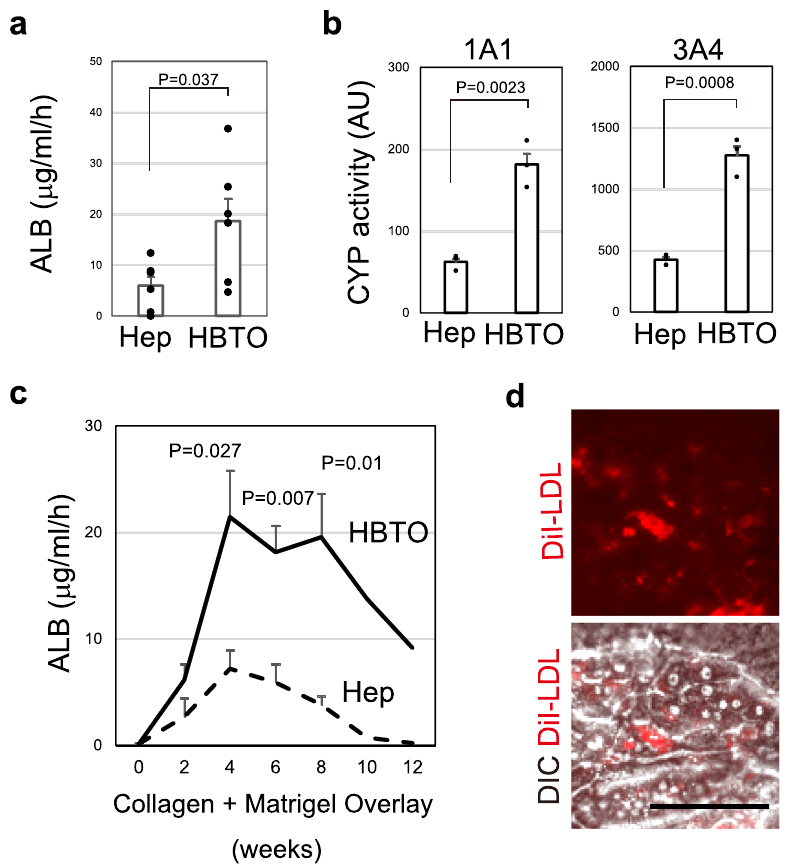
Fig. 4 Hepatocytes maintain metabolic functions in HBTO. a ALB secretion from hepatocytes and HBTOs. Hepatocytes in HBTOs secrete more ALB than those cultured alone. SHs were plated onto collagen gel with or without cholangiocyte colonies. Culture medium was collected, and ALB concentration was examined by ELISA four weeks after Col-MG overlay. Six wells ( n = 6) cultured independently were used to determine ALB concentration in the culture medium. Error bars represent SEM. Two-tailed unpaired t -tests were performed to compare ALB secretion between HBTO and SHs. b Activity of cytochrome P450s in hepatocytes and HBTOs. Hepatocytes in HBTOs show higher levels of CYP1A1, and CYP3A4-like activity than those cultured alone. CYP activities were examined three weeks after Col-MG overlay. The average values of CYP activity measured for three different culture wells ( n = 3) are shown in the graphs. Assays for the same number of wells were repeated two and three times, independently, for CYP1A1 and CYP3A4, respectively. Error bars represent SEM. Two-tailed unpaired t -tests were performed to compare CYP activities between HBTO and SHs. c Long-term maintenance of ALB secretion. ALB secretion gradually increases for four weeks after Col-MG overlay. Then, hepatocytes in HBTO maintain ALB secretion at a similar level for the following three to four weeks. ALB secretion was observed for two months for fi ve independent cultures ( n = 5); average values with SEM at each time point during a two-month period are shown in this fi gure. Two culture wells were further extended to measure ALB secretion at ten and twelve weeks after Col-MG overlay. Two-tailed unpaired t -tests were performed to compare ALB secretion between HBTO and SHs at 4, 6, and 8 weeks after MG-Col gel overlay, d Hepatocytes in HBTOs take up low-density lipoprotein (LDL). Hepatocytes in HBTOs can take up DiI-AcLDL in supplemented culture medium. HBTOs were maintained for four weeks and further incubated in the presence of DiI-AcLDL for 1 h. The experiment was repeated twice independently. Three fi elds were examined in each sample and the representative images are shown in this fi gure. A bar represents 100 μ